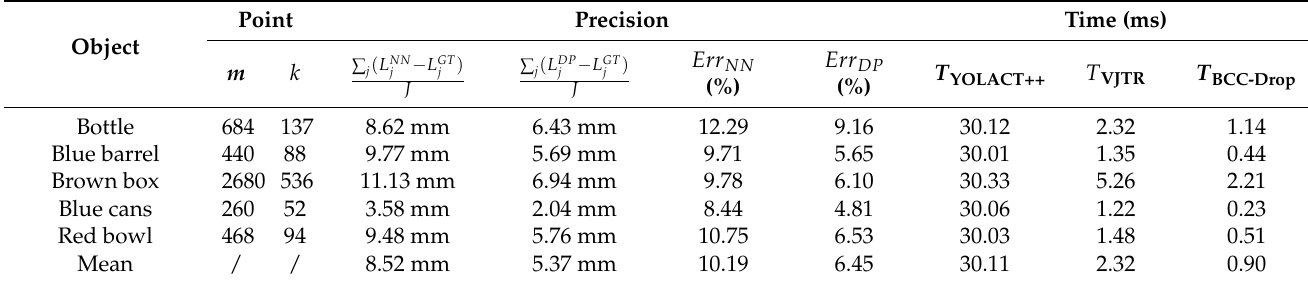
Table 4. The reconstruction accuracy and time cost on the YCB-Video